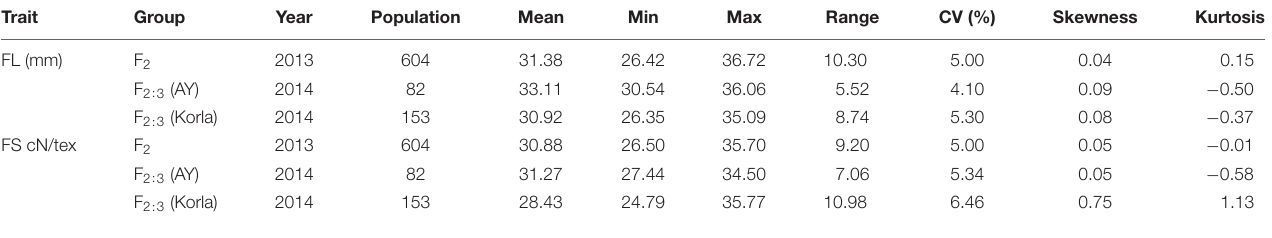
TABLE 2 | Descriptive statistics corresponding to fiber quality-related traits in the primary study populations. Trait Group Year Population Mean